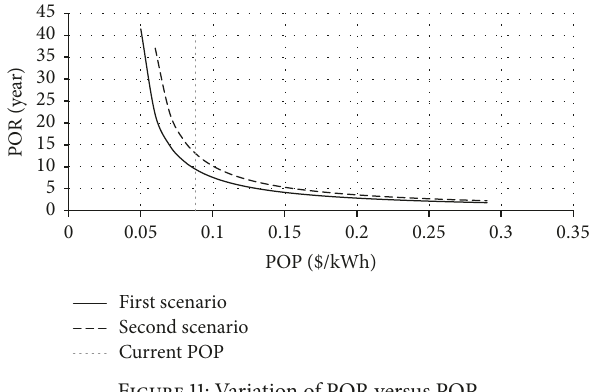
Figure 11: Variation of POR versus